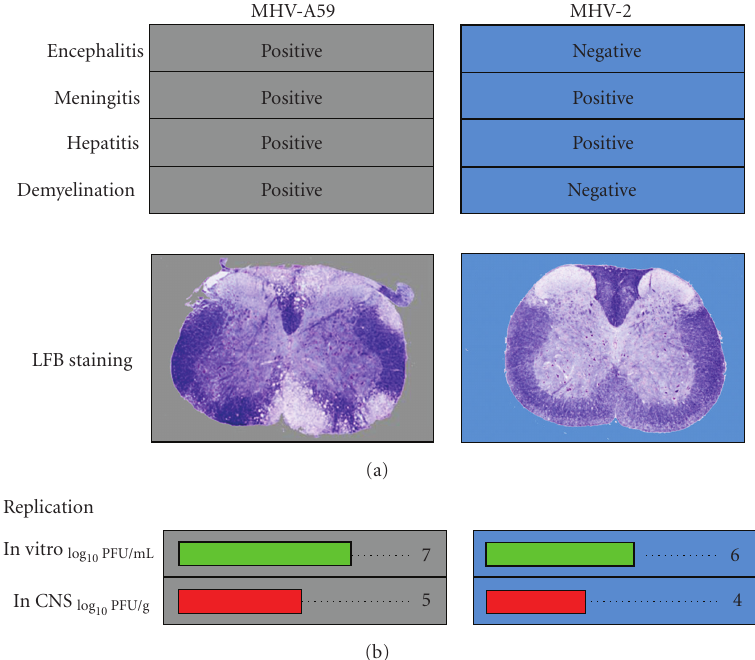
Figure 4: Index of di ff erential pathogenesis and replication of archetypical neurotropic strain, MHV-A59 and nonneurotropic primarily hepatotropic strain,